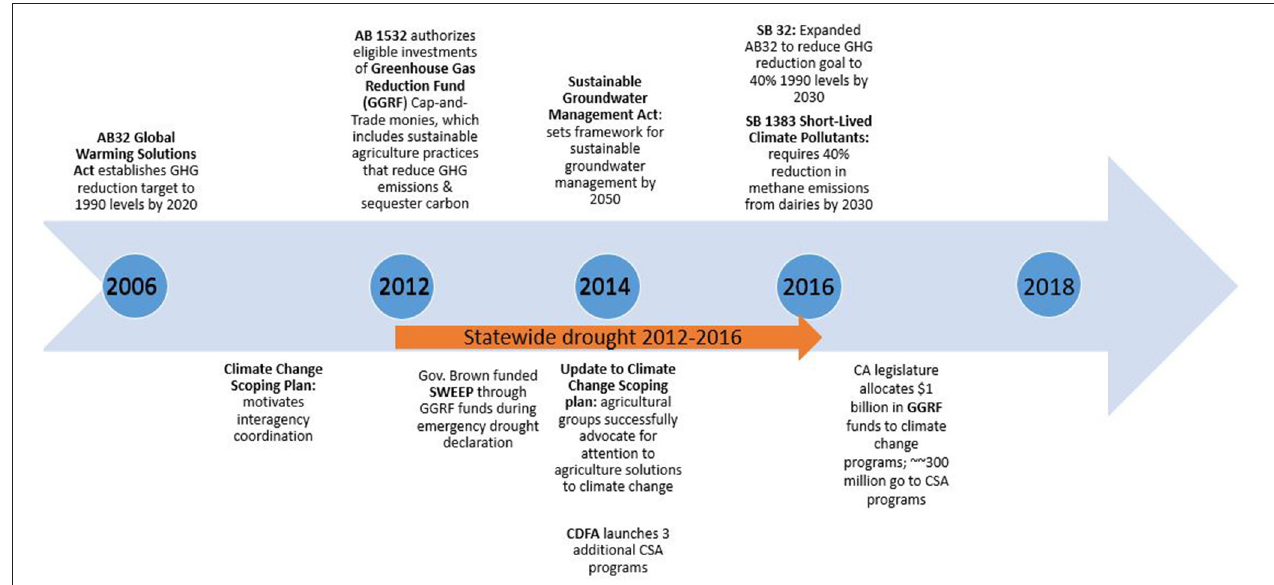
FIGURE 1 | Timeline of evolution of CSA policy environment. This figure provides a brief timeline enumerating key events in the development of multiple CSA policy initiatives in California. While not comprehensive of all initiatives discussed here, this shows how key events overlapped in time with other policy or environmental